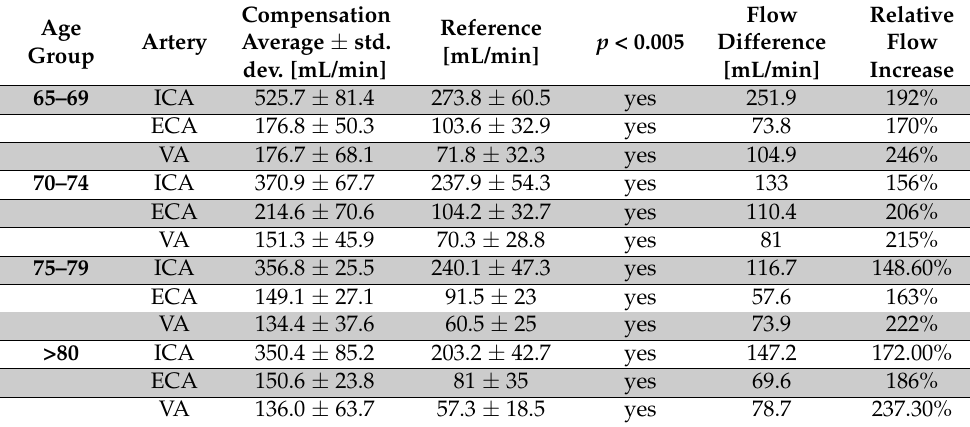
Table 4. The level of compensation in all extracranial